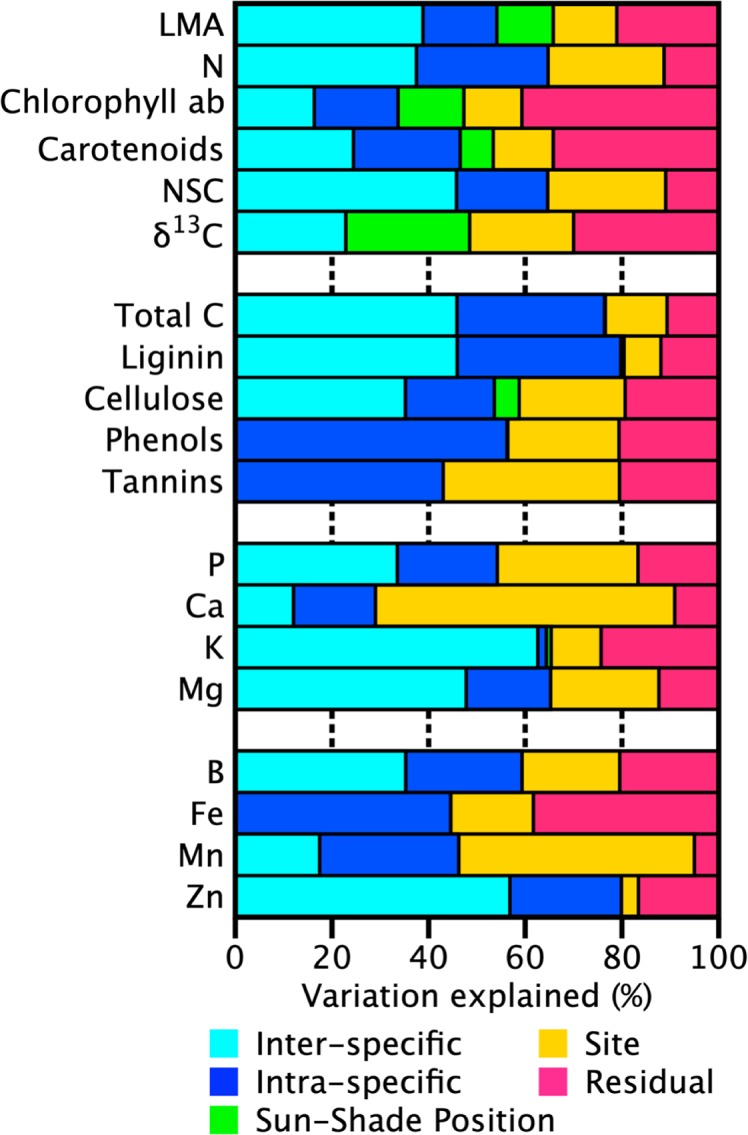
Partitioning of the variance for each tree canopy chemical trait into site, canopy position (sun or shade), phylogenetic variation, and unexplained residual variation for 10 sites along an Andean-Amazon gradient in Peru. The site component incorporates environmental variation in geology, topography, elevation, temperature, precipitation, radiation. Here, phylogenetic variation is separated into intraspecific and interspecific components (species and genera + family partitions respectively). Unexplained residuals are comprised of measurement error and other nonsite-related sources of uncertainty such as tree and foliage selection.